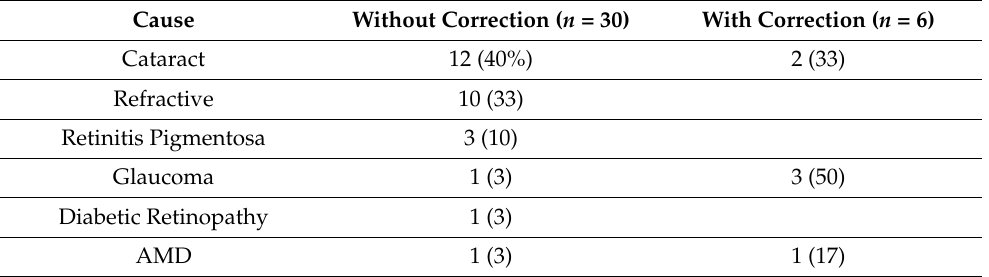
Table 4. Diagnoses,